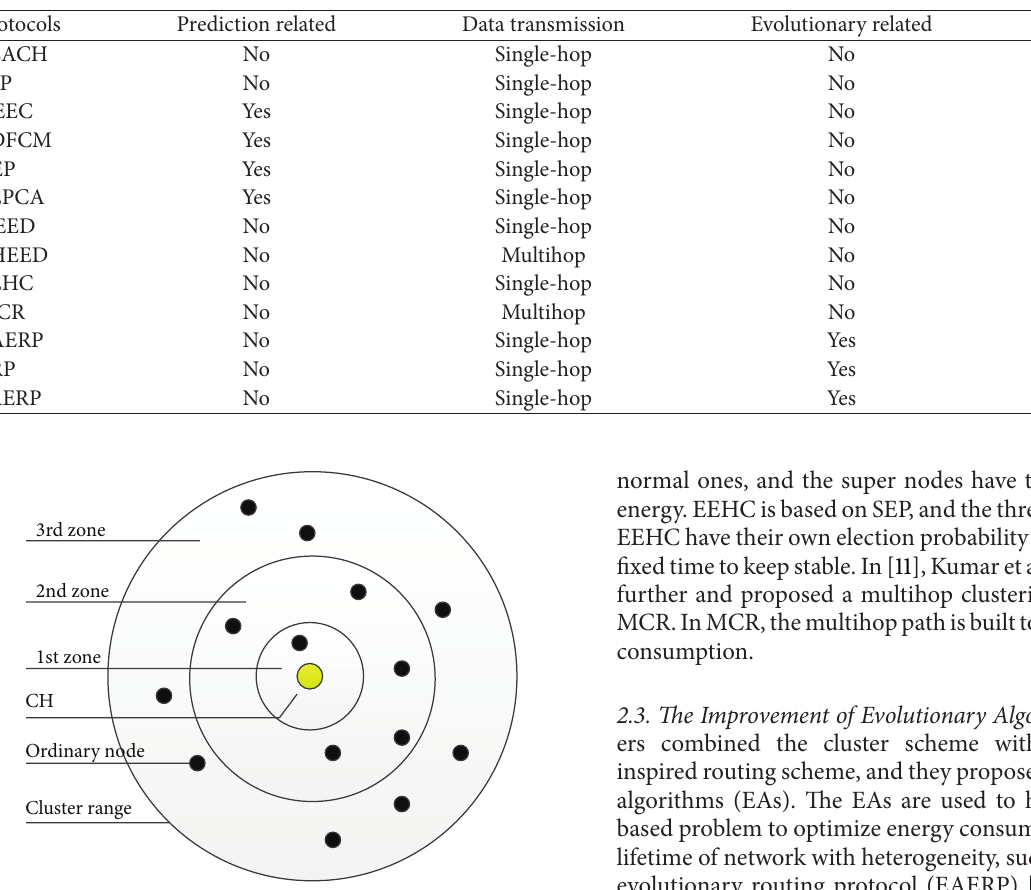
Table 1: Recent proposed routing protocols.